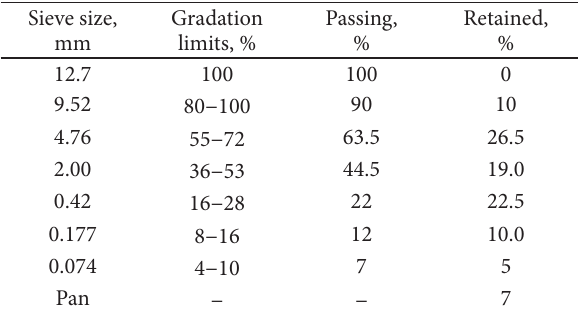
Table 4. Type 2 wearing course gradation (Highway Technical Specifications, 2006)